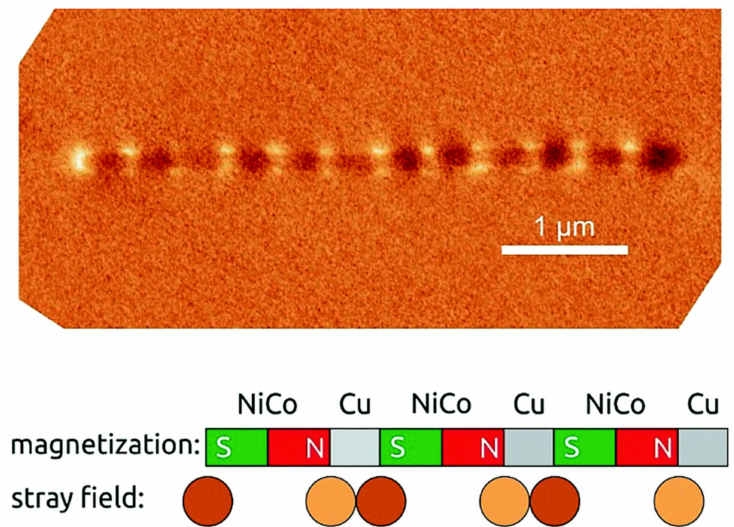
Figure 6. MFM images of an isolated Ni 60 Co 40 /Cu wire of diameter 40 nm ( top ); scheme of how the pattern observed in MFM originates from the alternation of magnetized and non-magnetic segments ( bottom ). Reprinted from [68] and originally published under a CC-BY